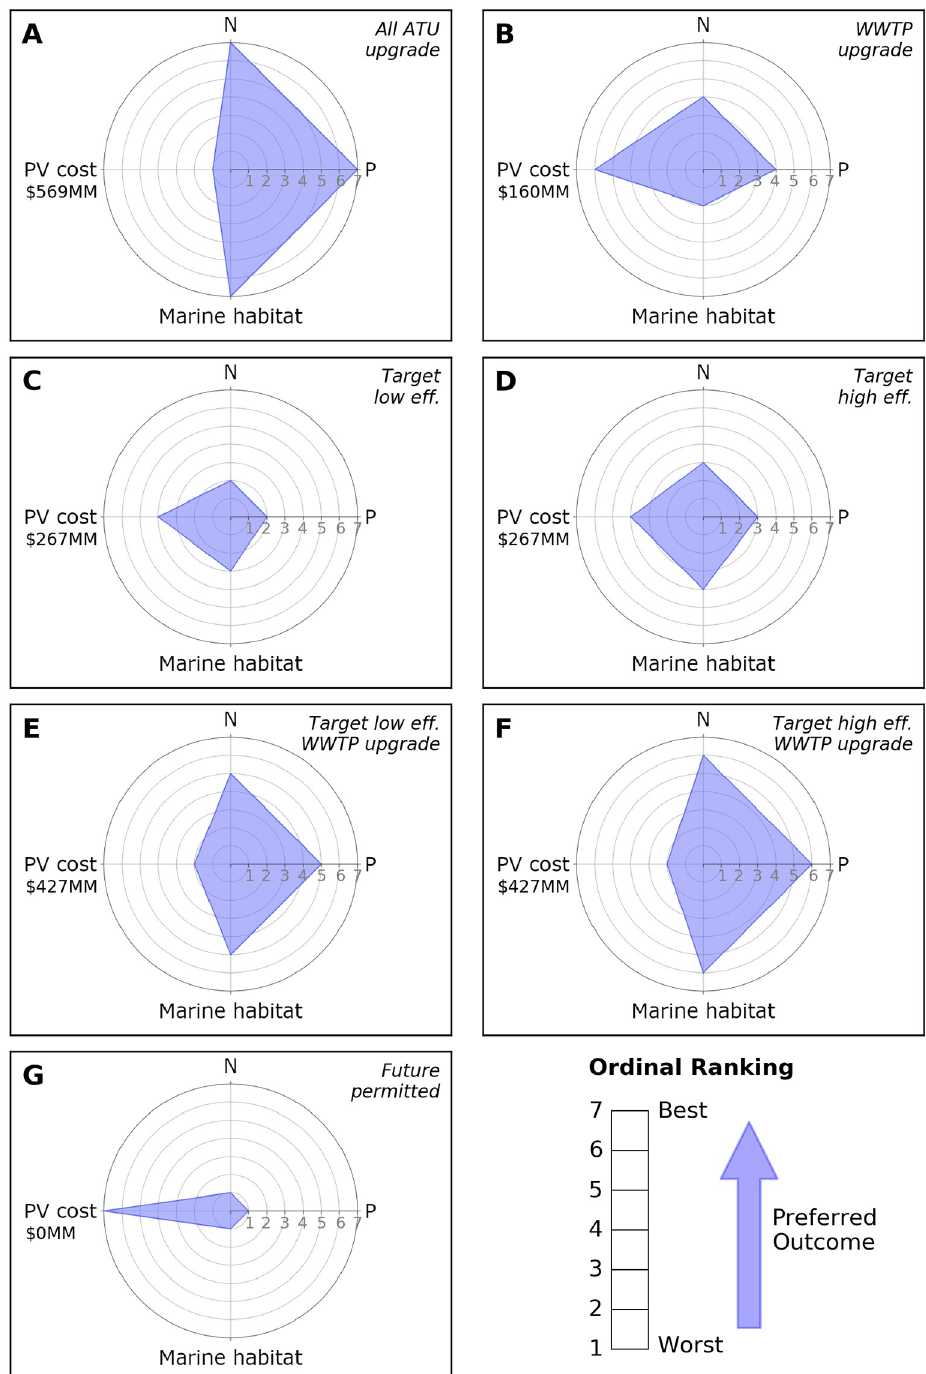
Fig 9. Spider diagrams for each management scenario illustrating tradeoffs between N reduction, P reduction, potential change in marine habitat quality, and present value cost.